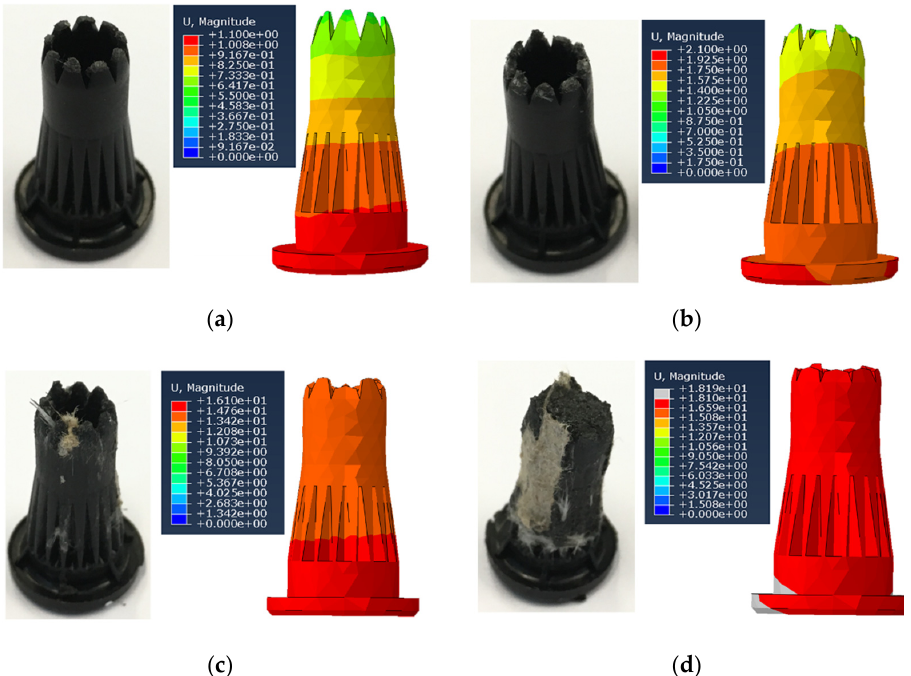
Figure 9. Observed and simulated pin damage rate at various collapse lengths: ( a ) Collapse length of 1 mm (before face sheet collapse); ( b ) Collapse length of 2 mm (after face sheet collapse); ( c ) Collapse length of 16 mm; ( d ) Maximum collapse length of 18 mm.